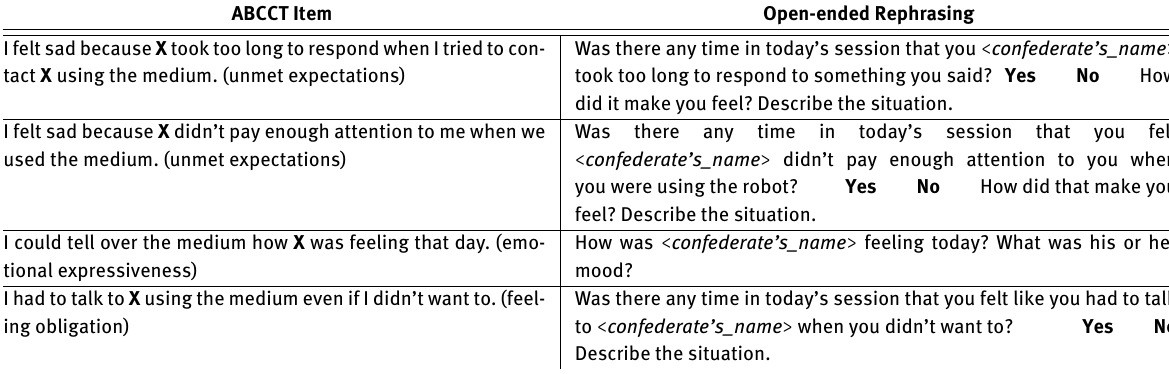
Table 8. Rephrasings of the Affective Benefits and Cost of Communication Technologies (ABCCT) questionnaire items [91] ABCCT Item Open-ended